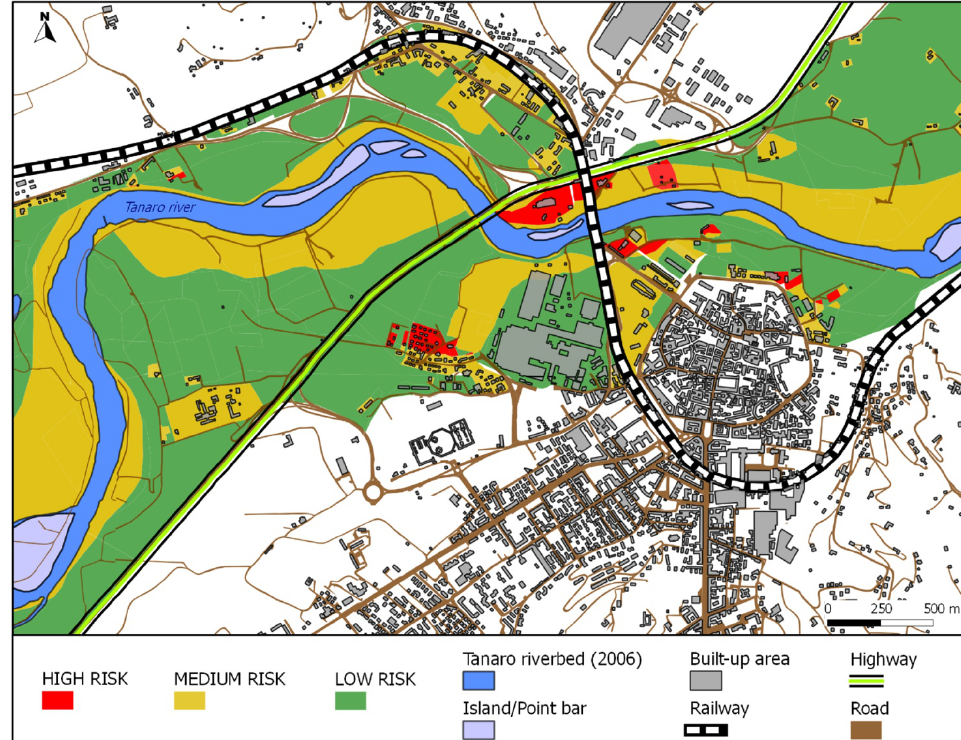
Fig. 11 – Final map in which areas with different flood-risk levels have been identified with different colors. River corridor C contains large residential areas, the courthouse, the Ferrero plants, other industrial and commercial areas, hotels, and scattered farms (Topino and Topinotto, zone A in figure 6; the Mogliasso- Vaccheria area, zone D in figure 6). Farms dot the entire Tanaro floodplain: their grain silos, barns and the new additions built by owners who have not considered the consequences are consistently exposed to risk.